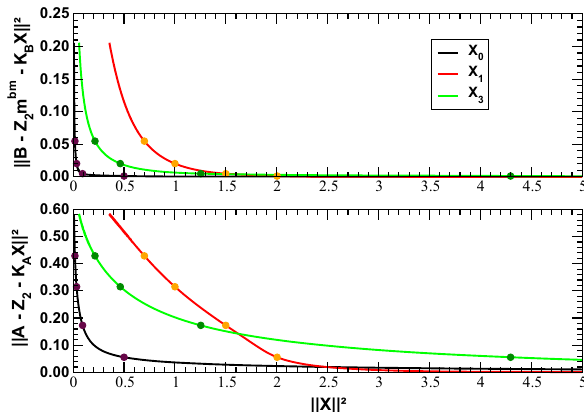
Fig. 18 Residuumversusnormforthescalarandvectorequationwhen solving the gap equation for X 0 , Y 1 and Y 3 . The smaller values of the regularising parameter (cid:19) are associated to solutions with larger norms, whilelargervaluesof (cid:19) produceformfactorswithsmallernorms.Recall that Y 1 has mass dimensions, while X 0 and Y 3 are dimensionless